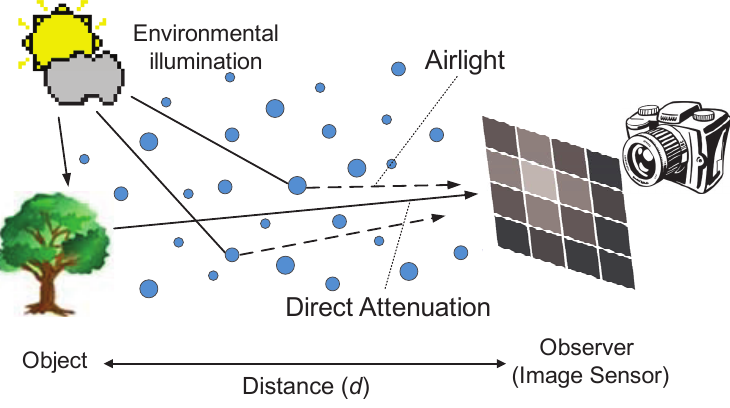
Figure 3. Effects of atmospheric scattering.